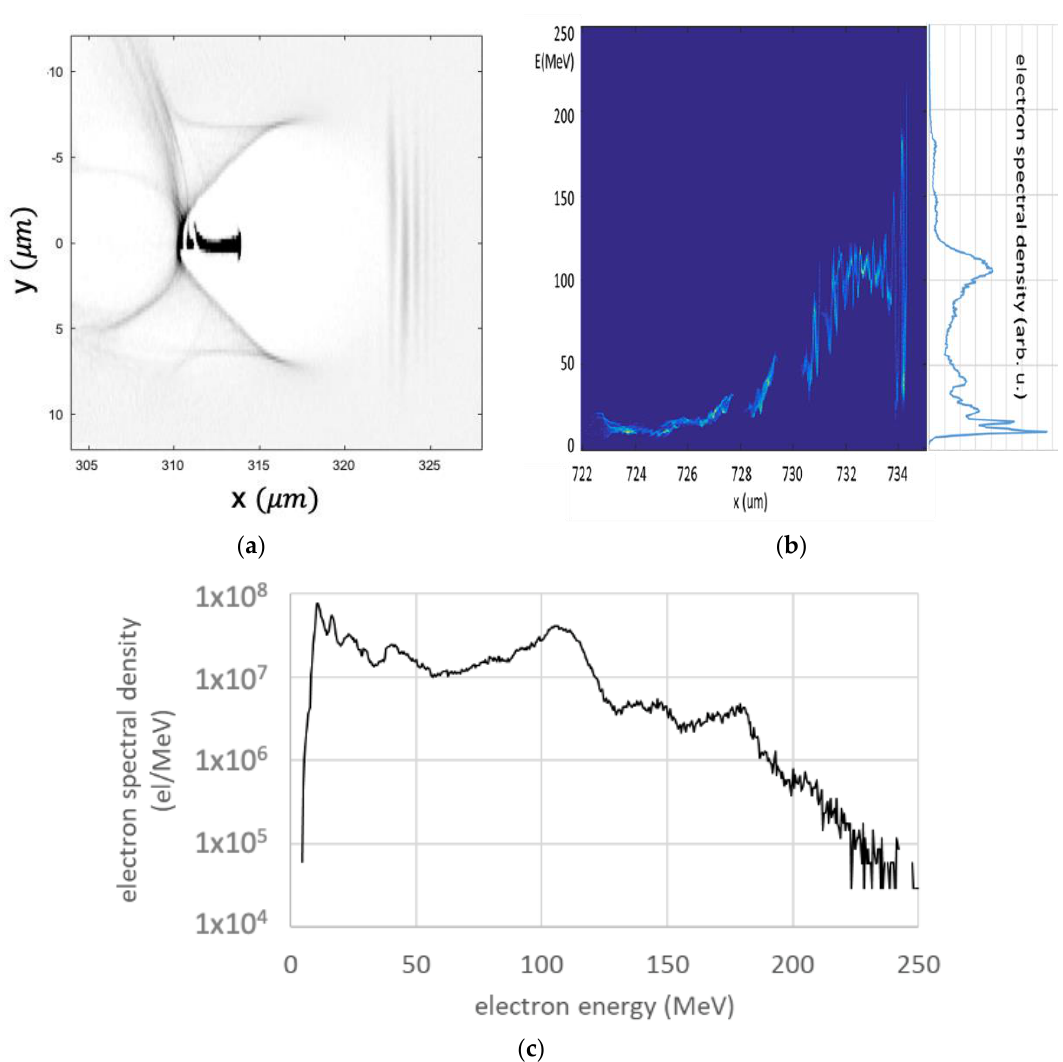
Figure 1. Electron density at the center of the density plateau ( a ), electron distribution function and spectrum after the plasma ( b ), spectrum on a log-lin plot ( c ).